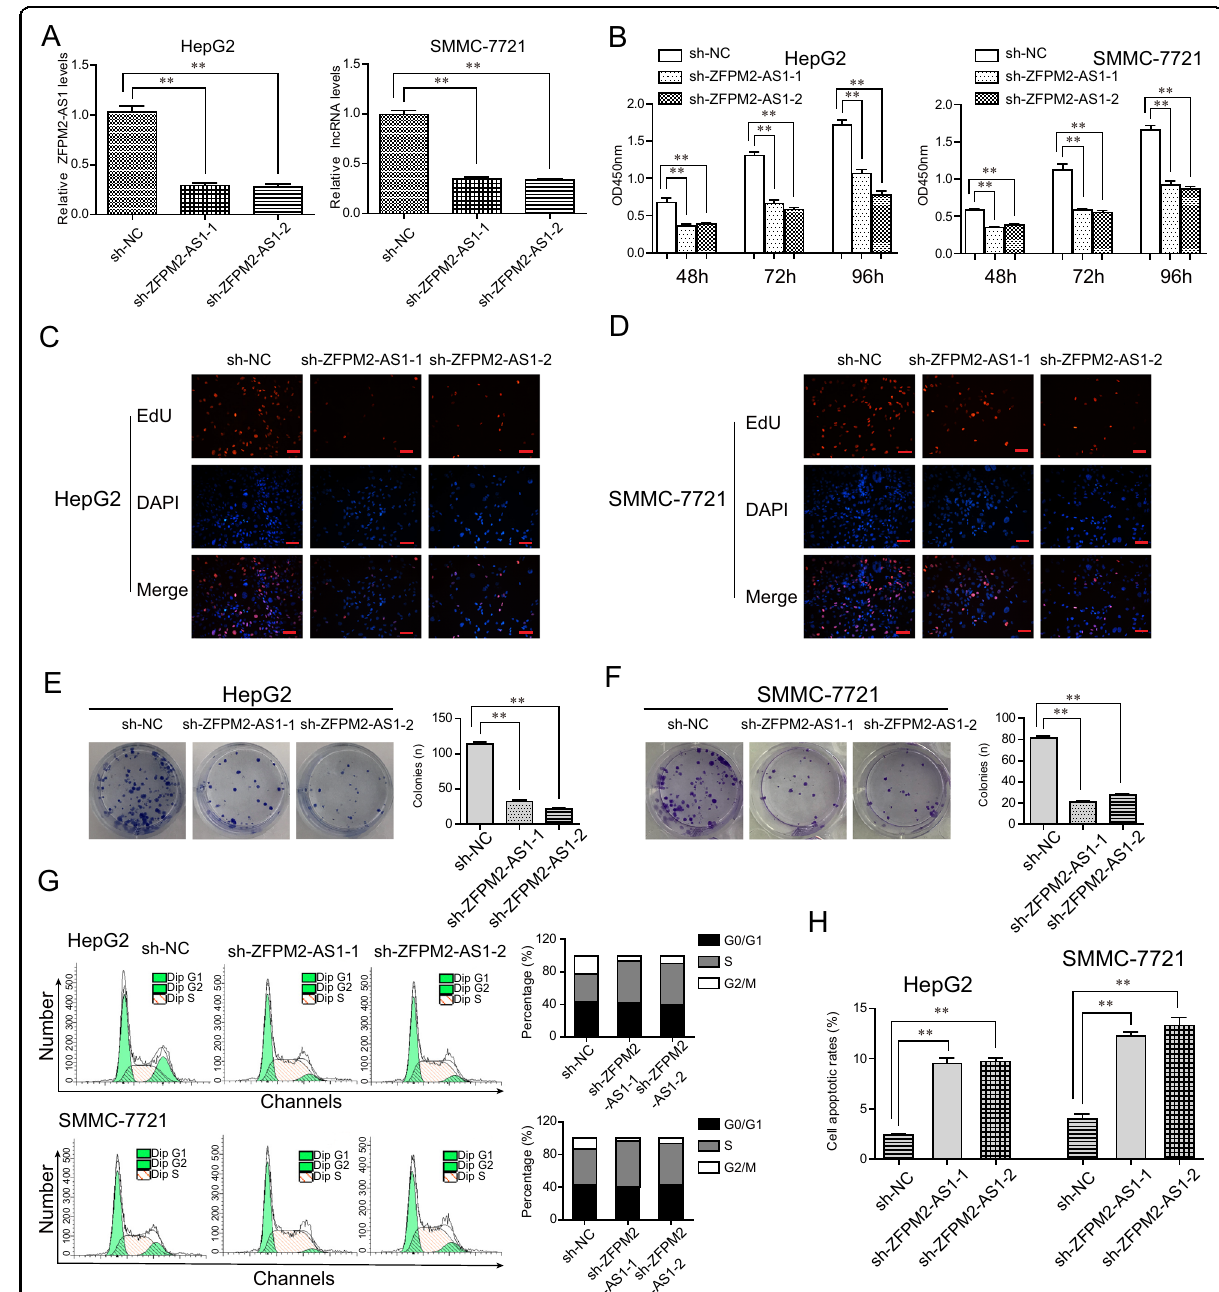
Fig. 3 ZFPM2-AS1 depletion suppressed cell growth and promoted cell apoptosis in HCC. A HepG2 and SMMC-7721 cells were infected with shRNA lentivirus speci fi cally targeting ZFPM2-AS1 (sh-ZFPM2-AS1-1, sh-ZFPM2-AS1-2), and the shRNA-knockdown ef fi ciency was evaluated by qPCR analyses. B The proliferation of HCC cells after infection was determined by CCK-8 assays. C , D EdU assays examined the proliferative cells (red). DAPI was used to stain the cellular nuclei (blue). Scale bar = 200 μ m. E , F Colony formation assays. G Flow cytometry analyzed the cell cycle of HCC cells after infection. H Cell apoptosis was determined by fl ow cytometry. Data are presented as the mean ± SD from three independent experiments. * P < 0.05, ** P <